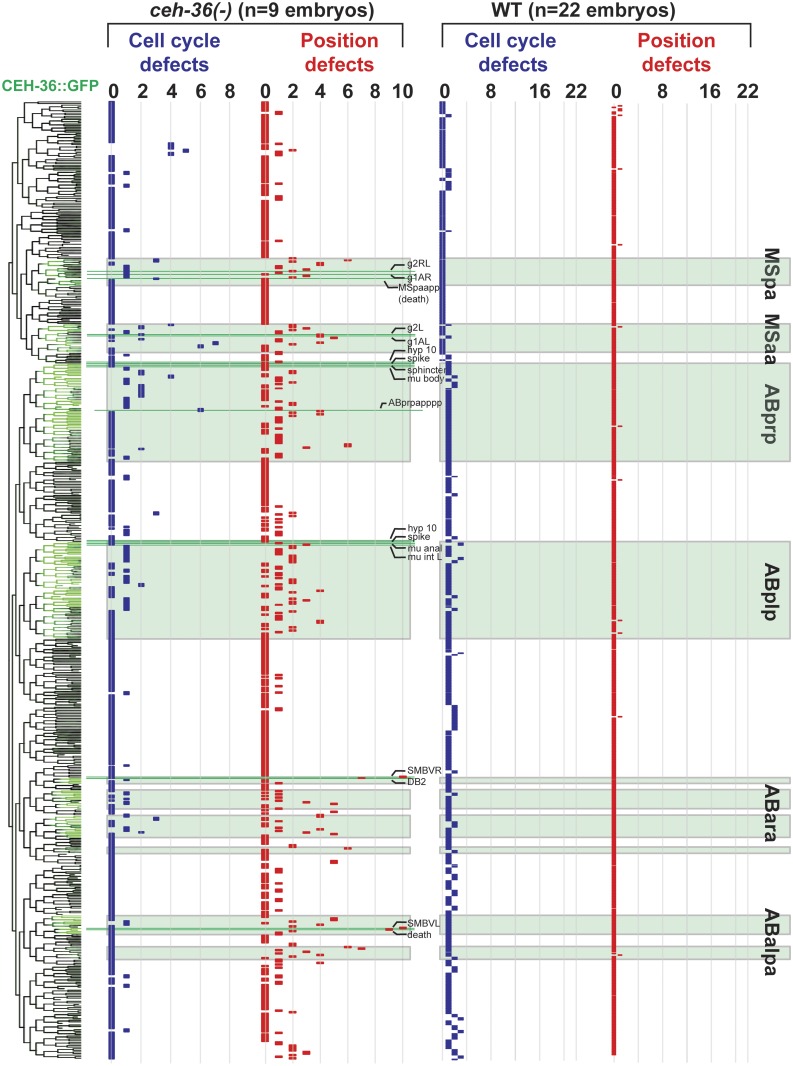
Lineage distribution and penetrance of cellular phenotypes in ceh-36 mutants.Lineage diagram with CEH-36::GFP expression (green) for reference. Columns show frequency of cell cycle (blue) and position (red) defects for each terminal cell across nine ceh-36 mutant embryos (eight carrying the ok795 deletion allele and one carrying ky646). CEH-36::GFP expressing lineages are labeled with green boxes. Lineage positions of cells discussed in the text or in Fig. 3 are labeled (pharyngeal glands = g1, g2, others labeled as described). Rare defects in progenitor cells were added to defects in terminal cells, allowing a few cells to have more than 9 cumulative defects.